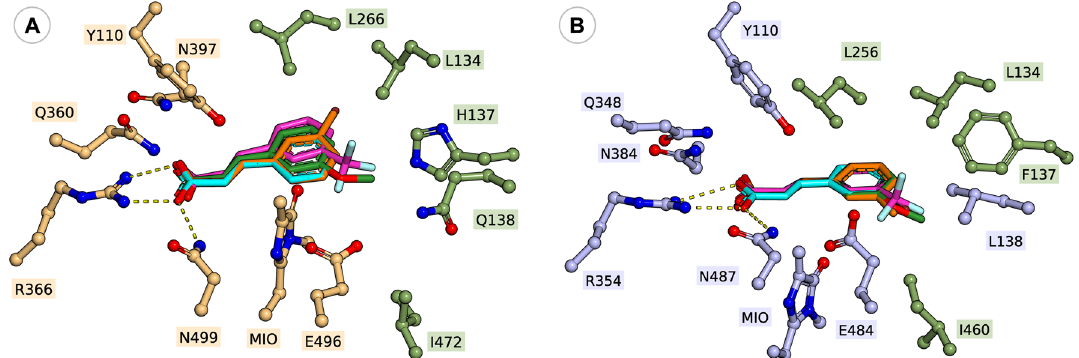
Figure 4. Active orientations of meta -substituted substrates m -Br-cinnamic acid 2e (cyan), m -CF 3 -cinnamic acid 2f (magenta), m -OCH 3 -cinnamic acid 2g (green) and m -CH 3 -cinnamic acid 2h (orange) within ( A ) wt - Rt PAL and ( B ) wt - Pc